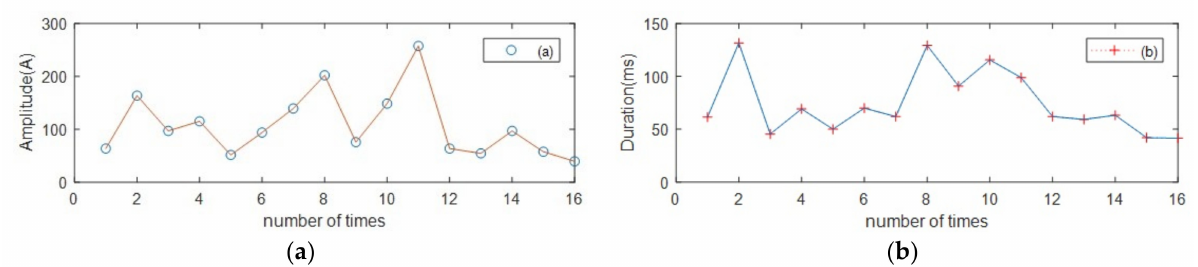
Figure 20. Statistics of key parameters of VFTC opening: ( a ) maximum amplitude of VFTC; ( b ) VFTC duration.